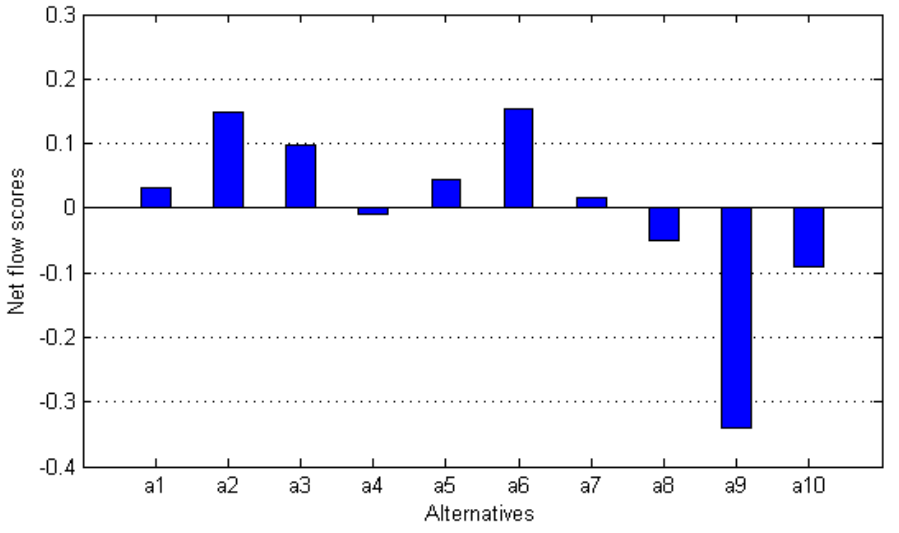
Figure 3. Ranking of the alternatives based on PROMETHEE II net flow scores Table 7 and Figure 3 represent the ranking of the solutions based on the PROMETHEE II net flow scores. The global net flow score is calculated by subtracting the positive to the negative net flow score. The alternatives a2, a3 and a6 are the preferred solutions of the problem according to the preferences of the decision maker. Table 7. PROMETHEE II net flow